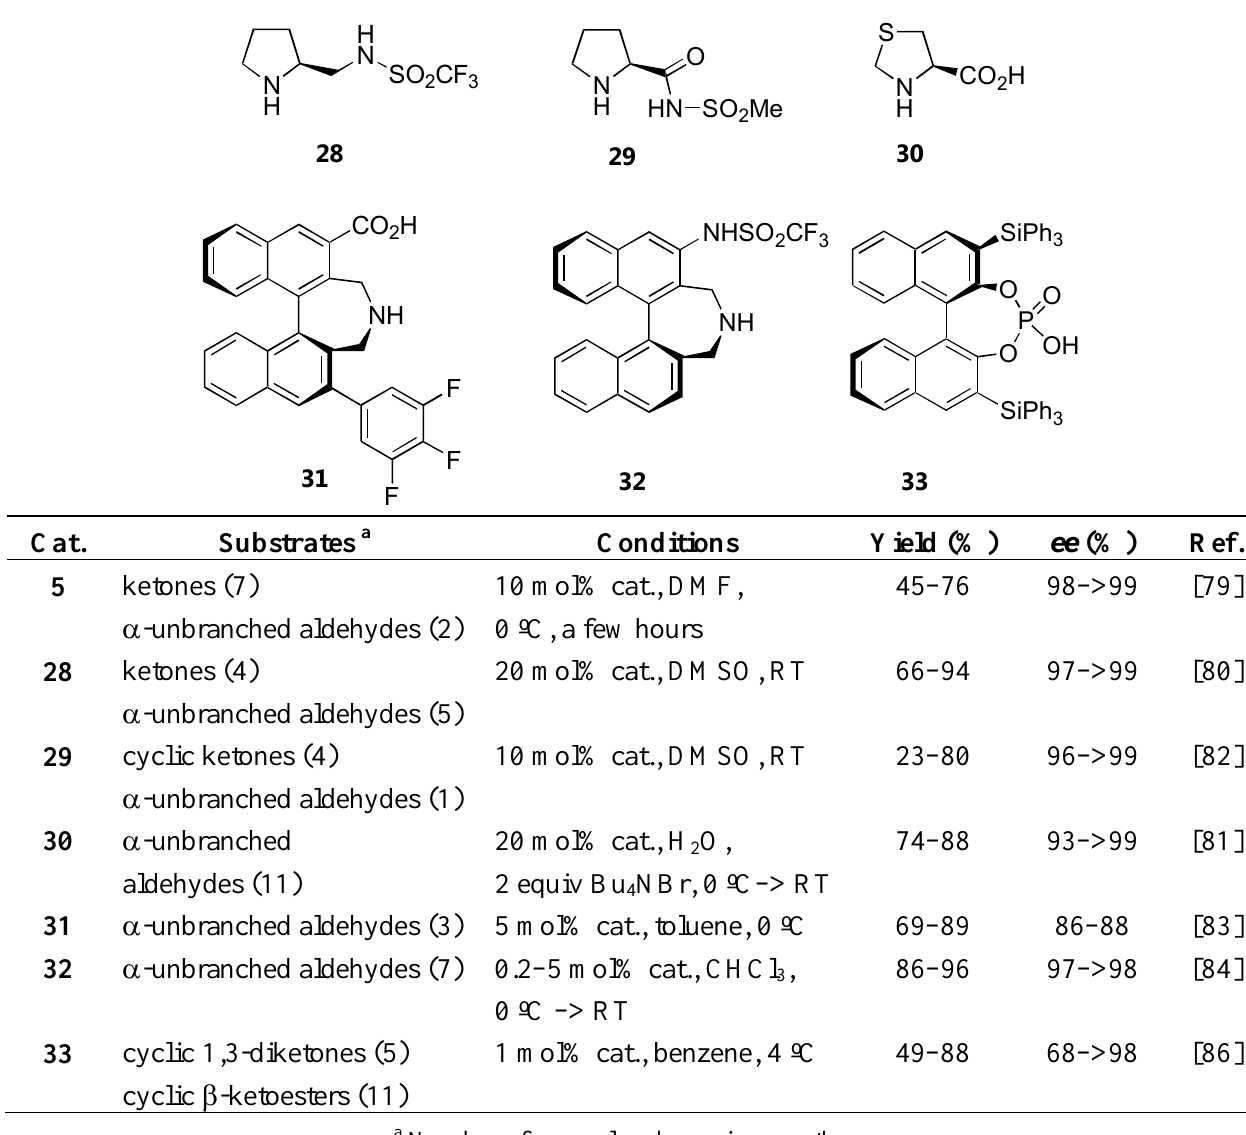
Table 7. Summary of performance of other proline- and nonproline-based catalysts in  - aminoxylation of carbonyl